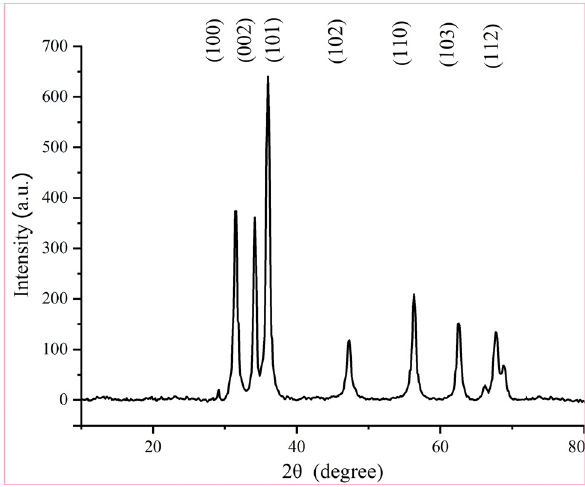
Figure 2: XRD pattern of the biogenic